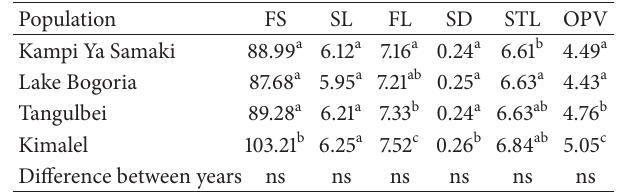
Table 4: Floral characteristics of S. senegal within Lake Baringo woodland ecosystem.